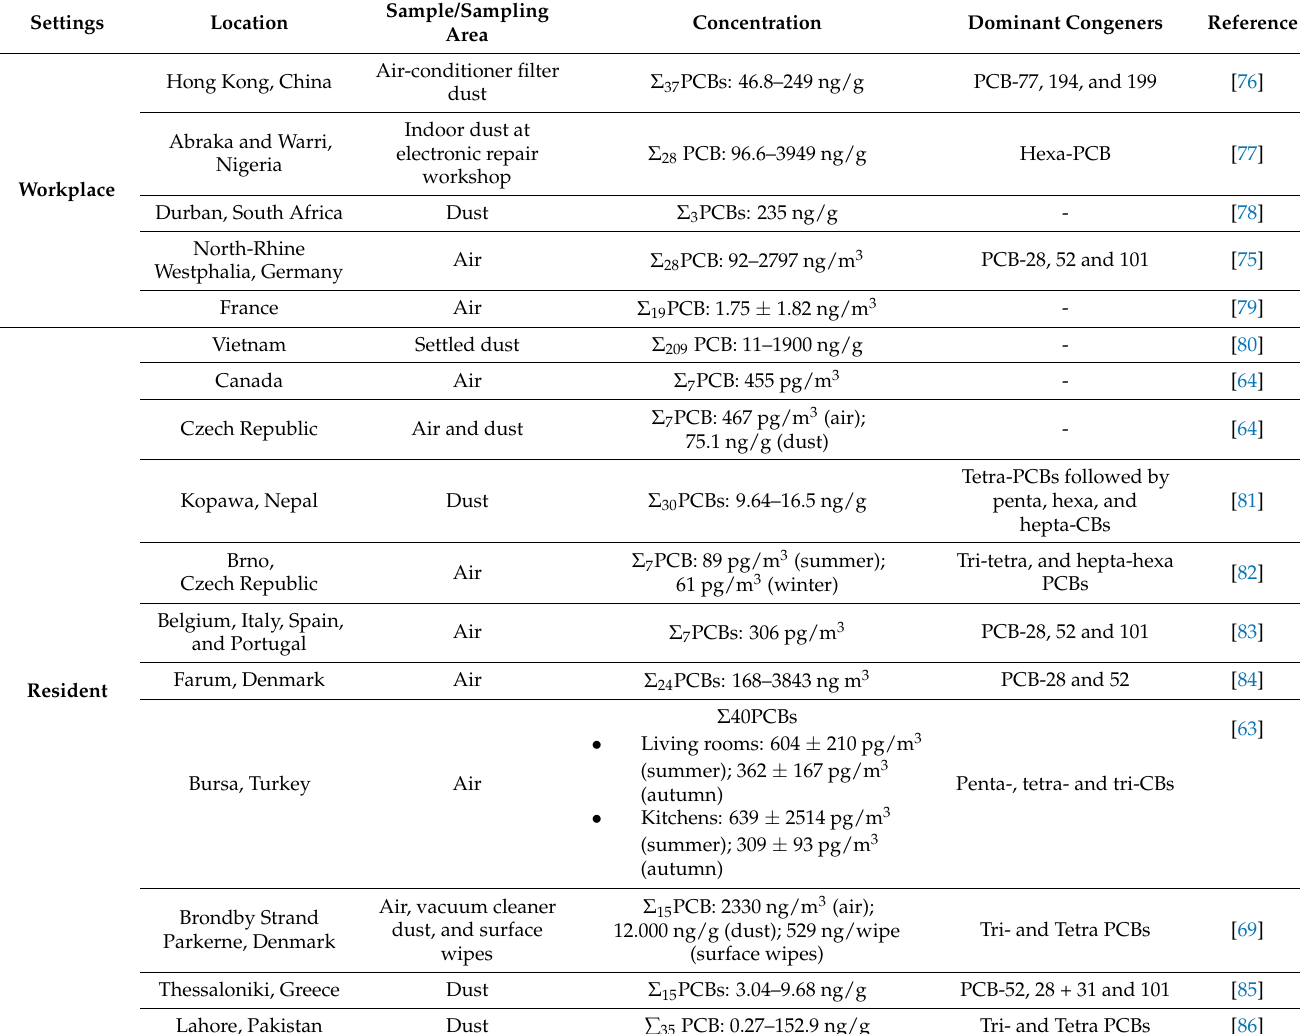
Table 2. Concentration of PCBs in indoor environments in different